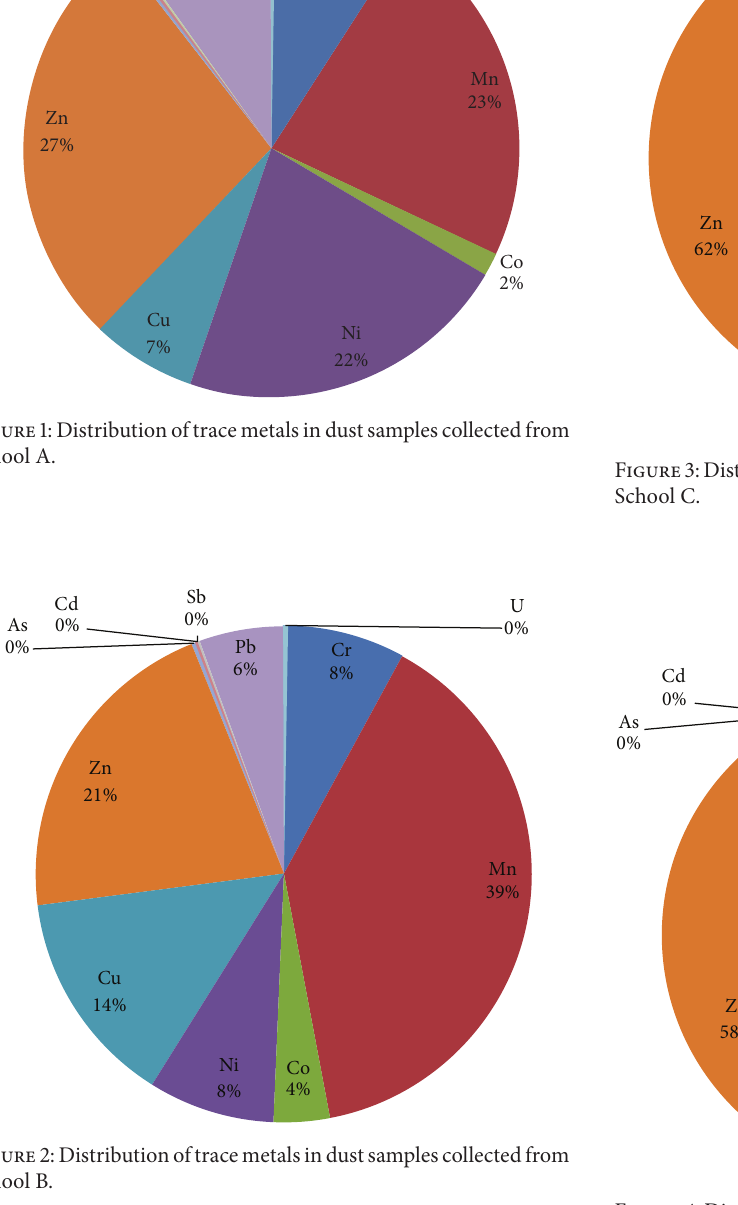
Figure4:Distributionoftracemetalsindustsamplescollectedfrom School